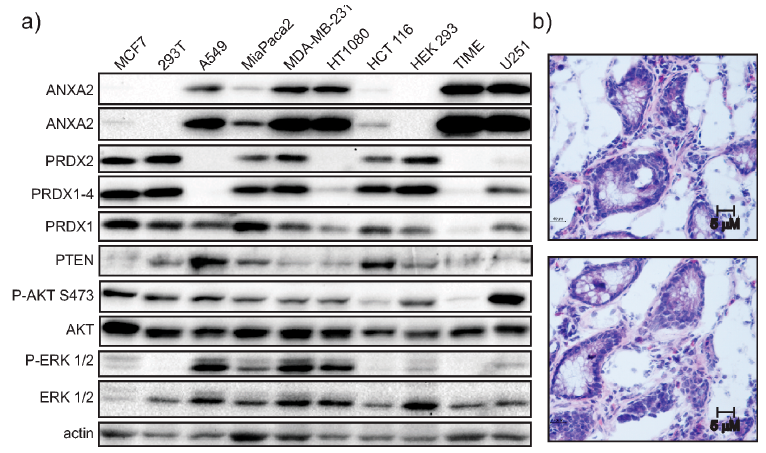
Figure 4. Cont . Figure 4. Cont .